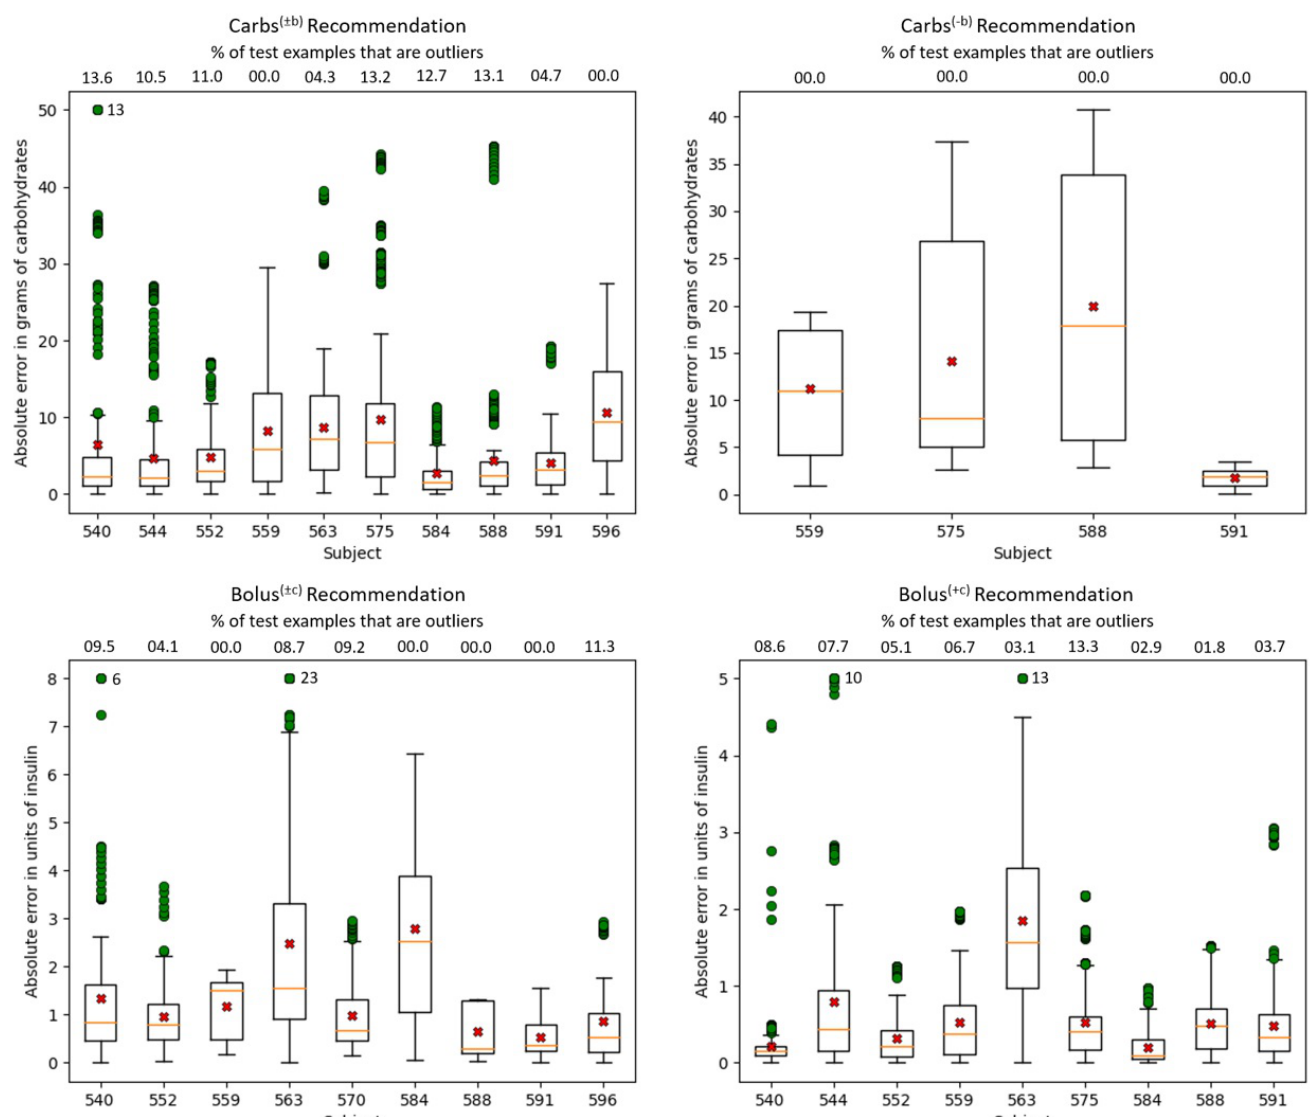
Figure 4. Boxplots showing the absolute error per subject for each recommendation scenario achieved by the N-BEATS.best model in the inertial scenario. The orange lines within each box represent the median absolute errors, while the red crosses represent the average absolute errors. The green circles represent outliers. To avoid stretching the figures, outliers were clipped at 25 for the Carbs ( ± b ) scenario, 8 for the Bolus ( ± c ) scenario, and 5 for the Bolus (+ c ) scenario. The number of clipped outliers is shown next to the subject’s largest outlier. Above the top line is shown, for each subject, the percentage of test examples that are